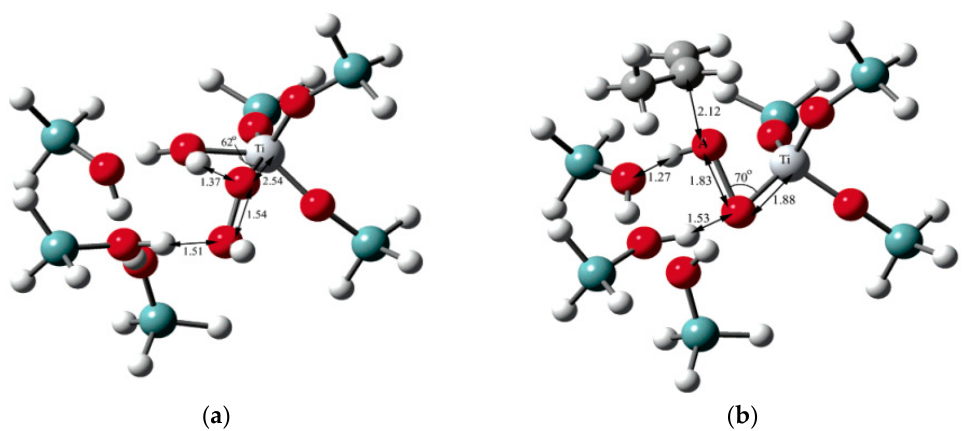
Figure 5. Ti/defect mechanism for the full silanol system: ( a ) transition-state geometry for the formation of the hydroperoxy intermediate on the Ti site of TS-1, and ( b ) transition-state geometry for propylene epoxidation [104]. Distances shown are in units of angstroms. Copyright © 2006 American Chemical Society.